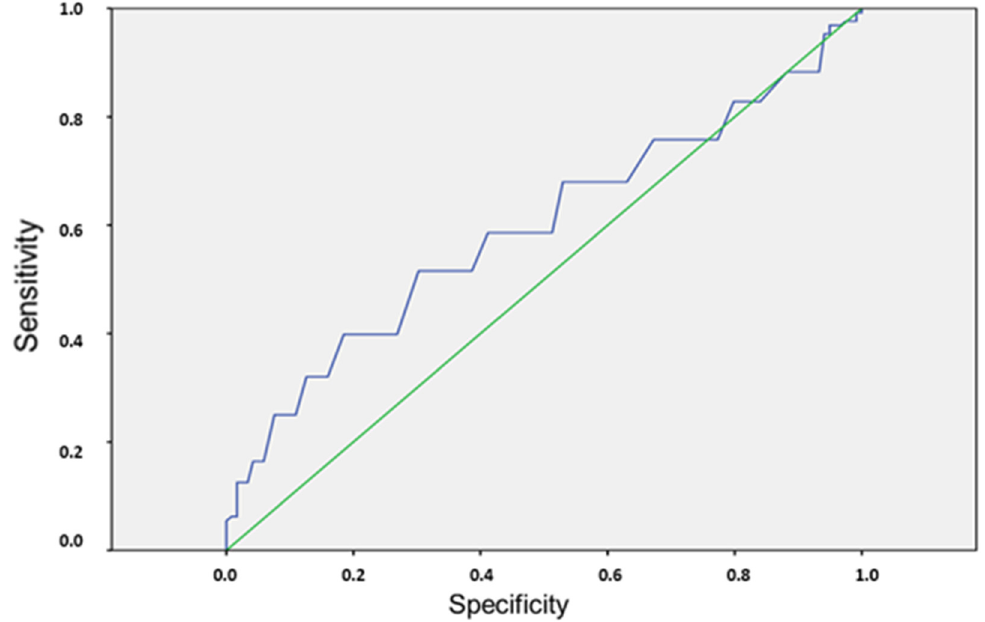
Figure 1. Receiver operating curve (ROC) of intra-abdominal pressure (IAP) recorded immediately before the first gastrointestinal complication in patients with gastrointestinal complications (group B) or the mean daily IAP recorded in patients without gastrointestinal complications (group A). Area under the curve = 0.595, indicating a low diagnostic power of IAP to predict gastrointestinal complications.